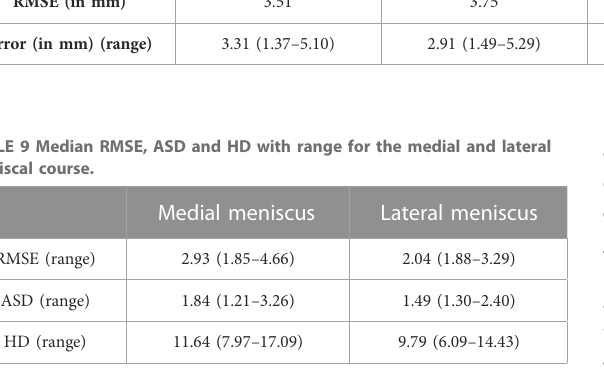
TABLE 8 The RMSE and the median error with range from minimal to maximal error for medial and lateral meniscus anterior and posterior root. Anterior root Medial meniscus Lateral meniscus Posterior root Medial meniscus Lateral meniscus